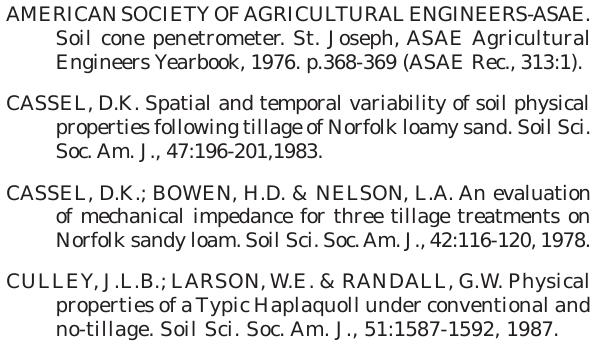
Table 2. Soil water content distribution at time of penetrometer